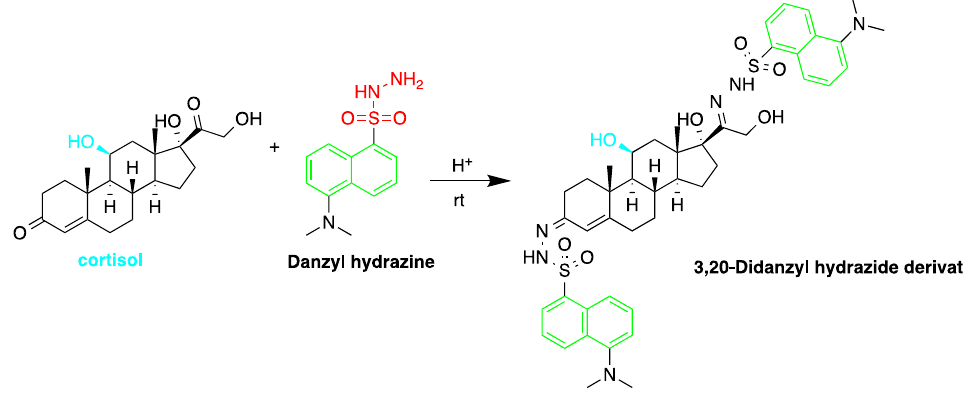
Figure 7. Fluorescent derivatization of carbonyl functionality of cortisol by dansyl hydrazine. The detection of corticosteroids with ketolic groups in urine is key part in diagnostic procedure of Cushing’s syndrome. Ketol-containing corticosteroids, such as 17-hydroxycorticosteroid (breakdown product of cortisol), are usually excreted in urine as tetrahydro form making their detection using UV absorption at 240 nm not possible. To detect these steroids in urine, derivatization with amidine-containing compounds was used yielding fluorescent compounds [60] (Figure 8). Using this approach, the best sensitivity was achieved for cortisol.